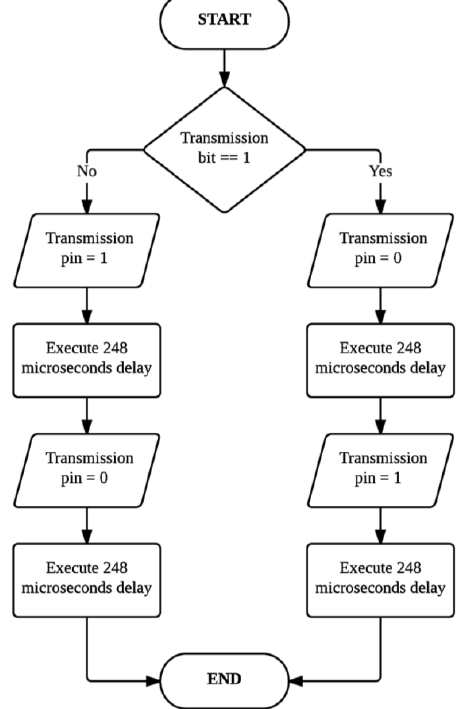
Figure 7. The Manchester encoding subroutine of the transponder data carrier.